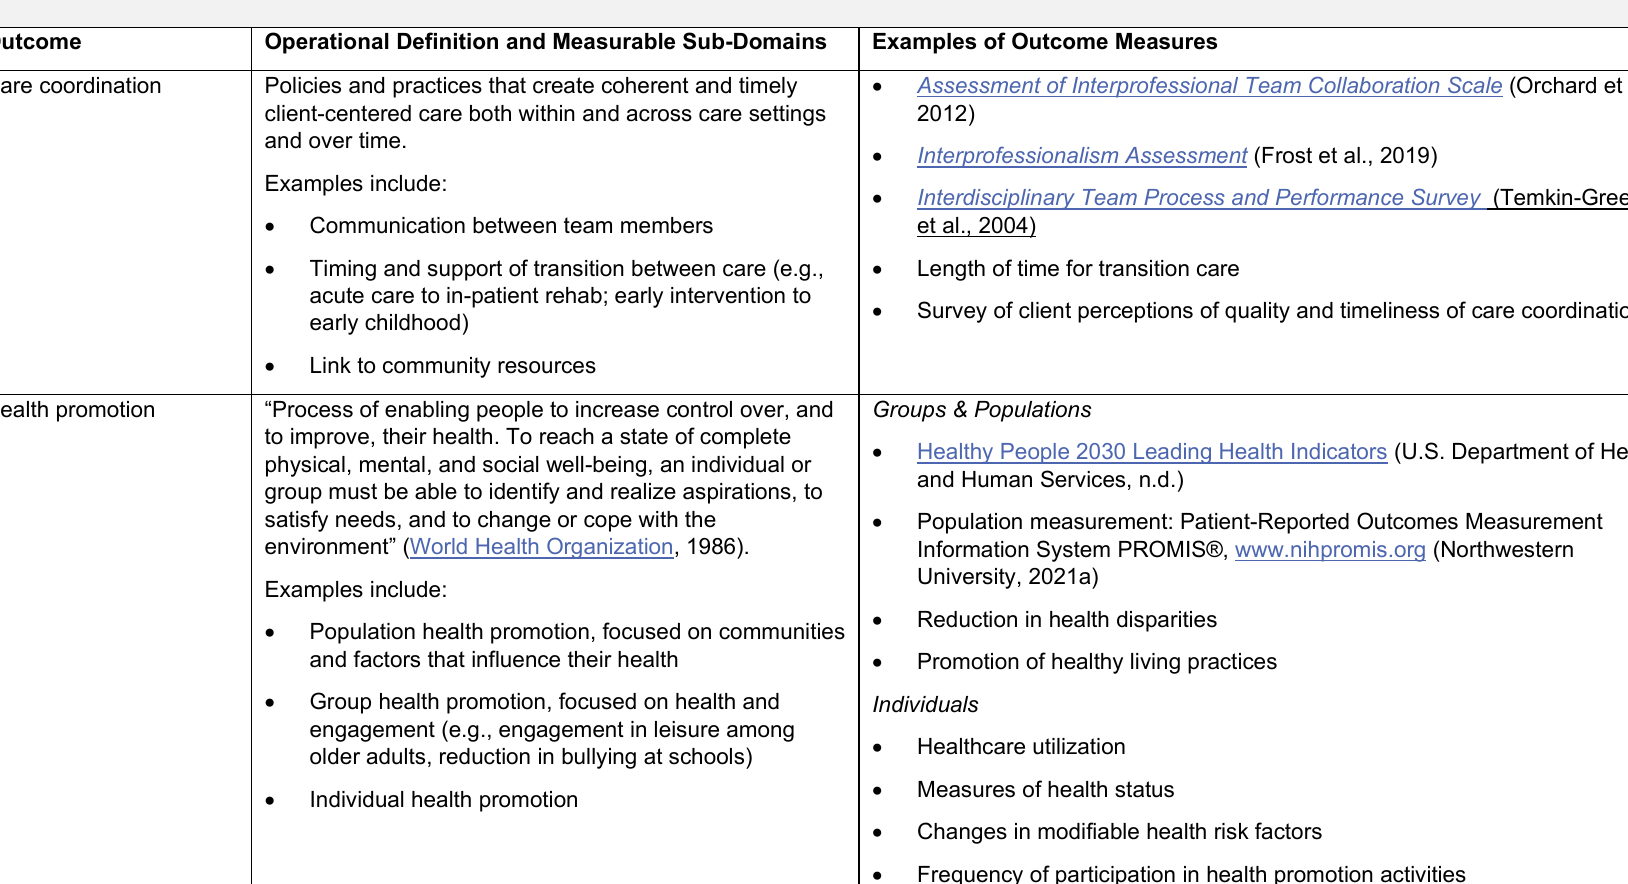
Population and Health Outcomes